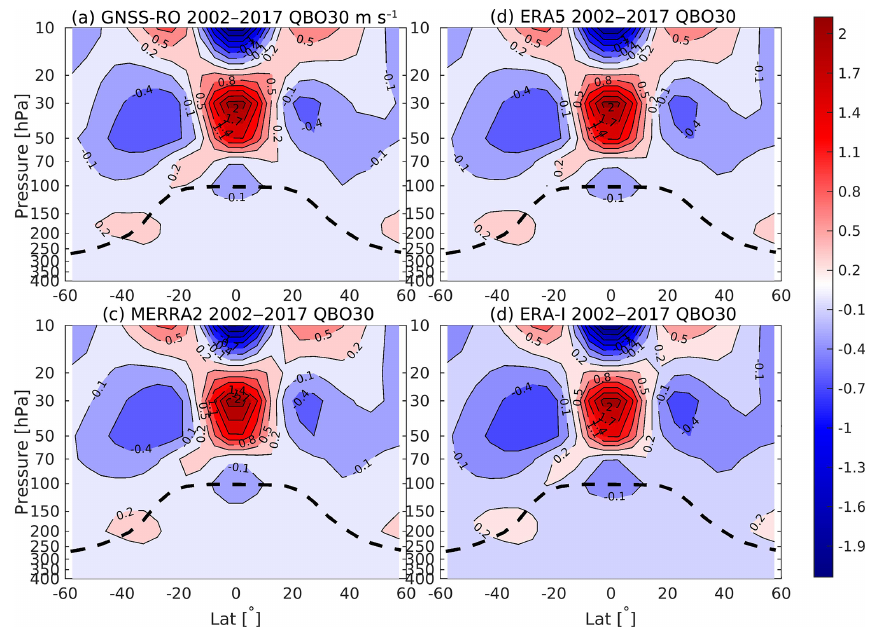
Figure 10. As in Fig. 8 but for